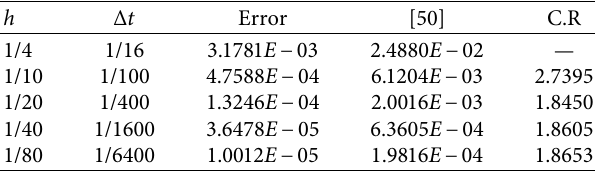
Table 5: Errors norm of Y at diferent step